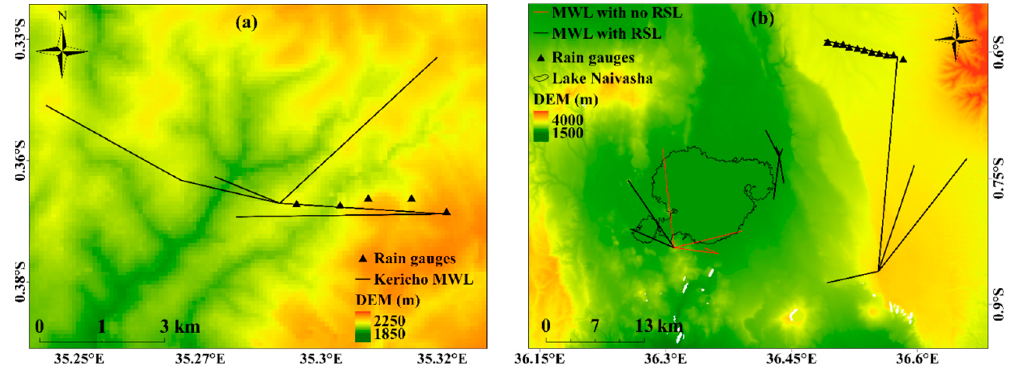
Figure 1. The locations of MWL and rain gauges in ( a ) Kericho and ( b ) Naivasha. The base map is SRTM DEM over the two study locations. Note: map coordinates are shown in decimal degrees, for some of the MWL in Naivasha no RSL data were available (red lines in ( b )).